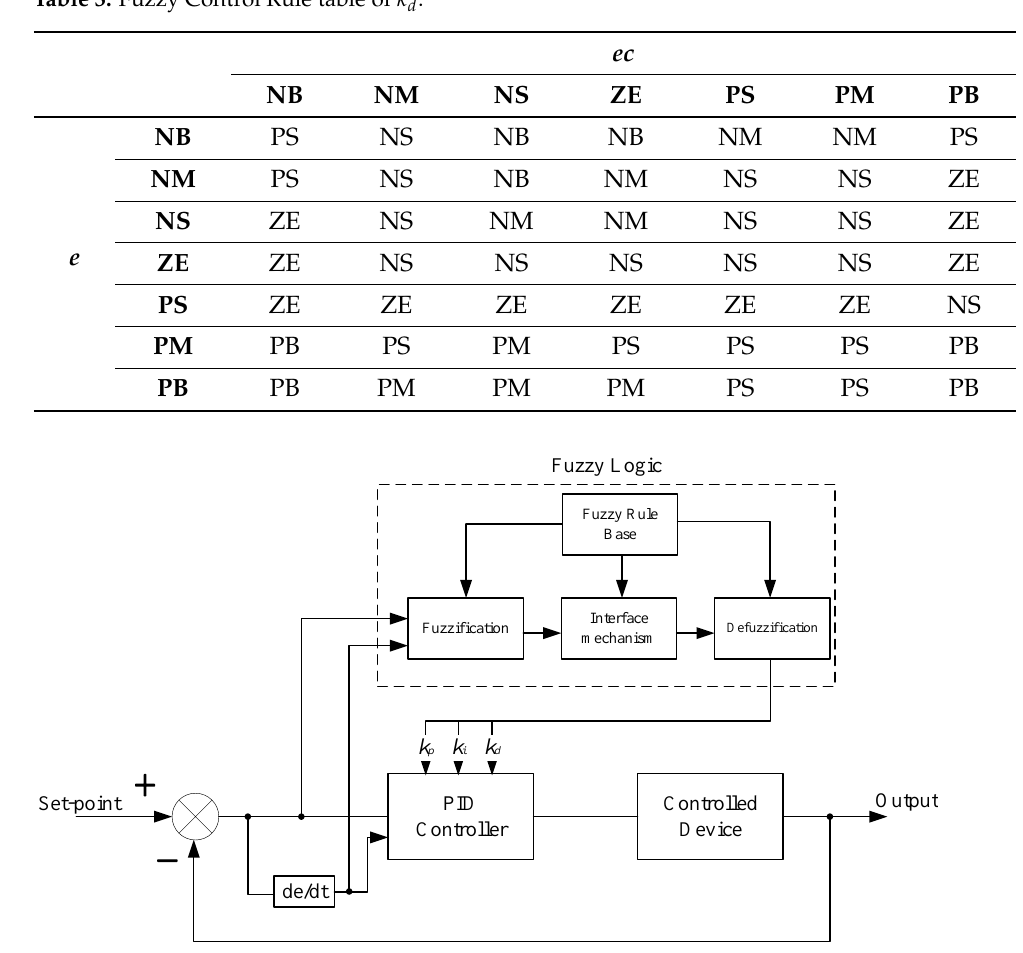
Table 3. Fuzzy Control Rule table of k d .